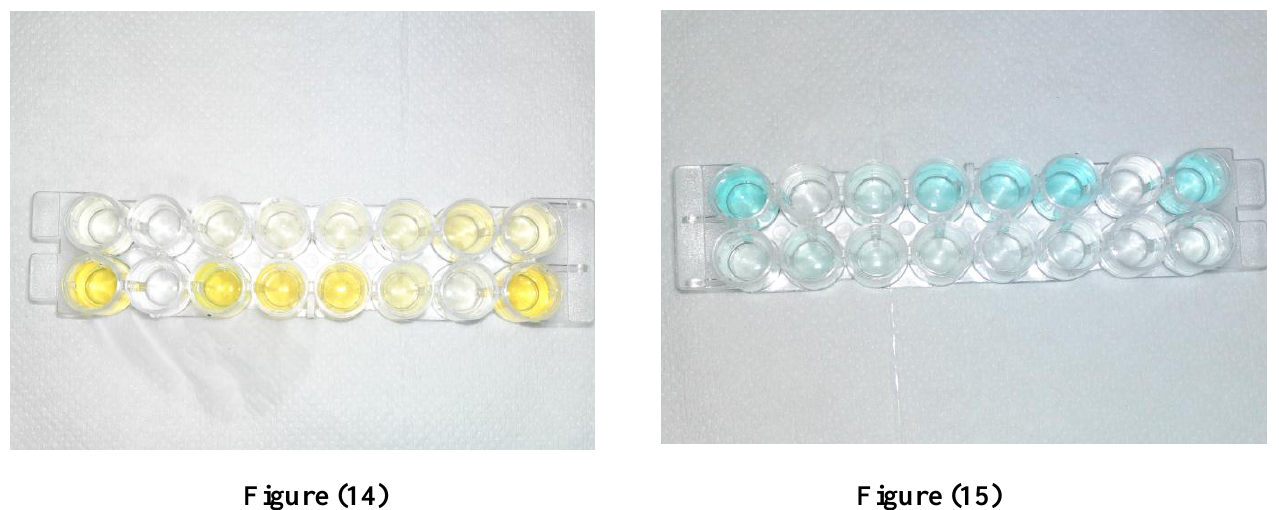
Figure (14, 15): Positive results of ELISA test for sera of infected animals from which virus was